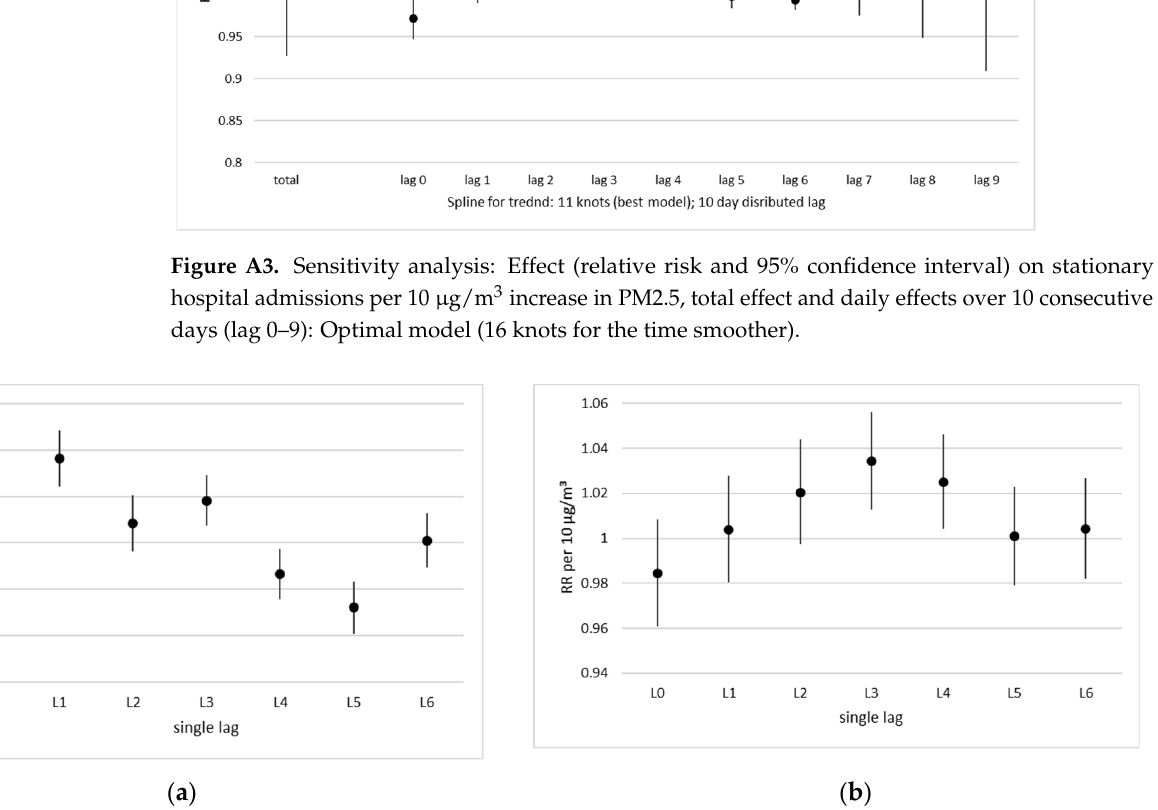
Figure A4. Effect (relative risk and 95% confidence interval) per 10 μ g/m³ increase in PM2.5, daily effects over 7 single consecutive days (lag 0–6): ( a ) ambulatory visits, ( b ) stationary hospital admis ‐ sions.